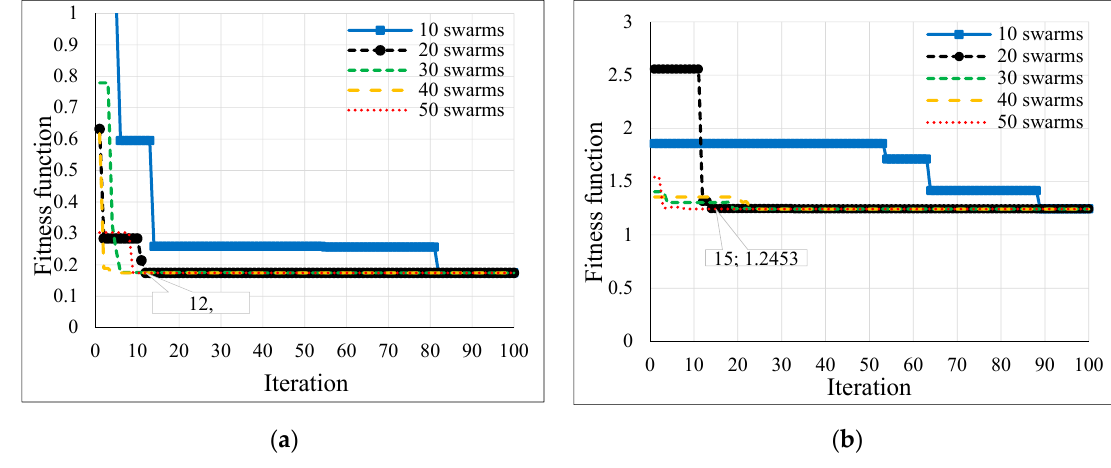
Figure 14. PSO fitness function versus iteration for ( a ) outdoor and ( b ) indoor velodromes.